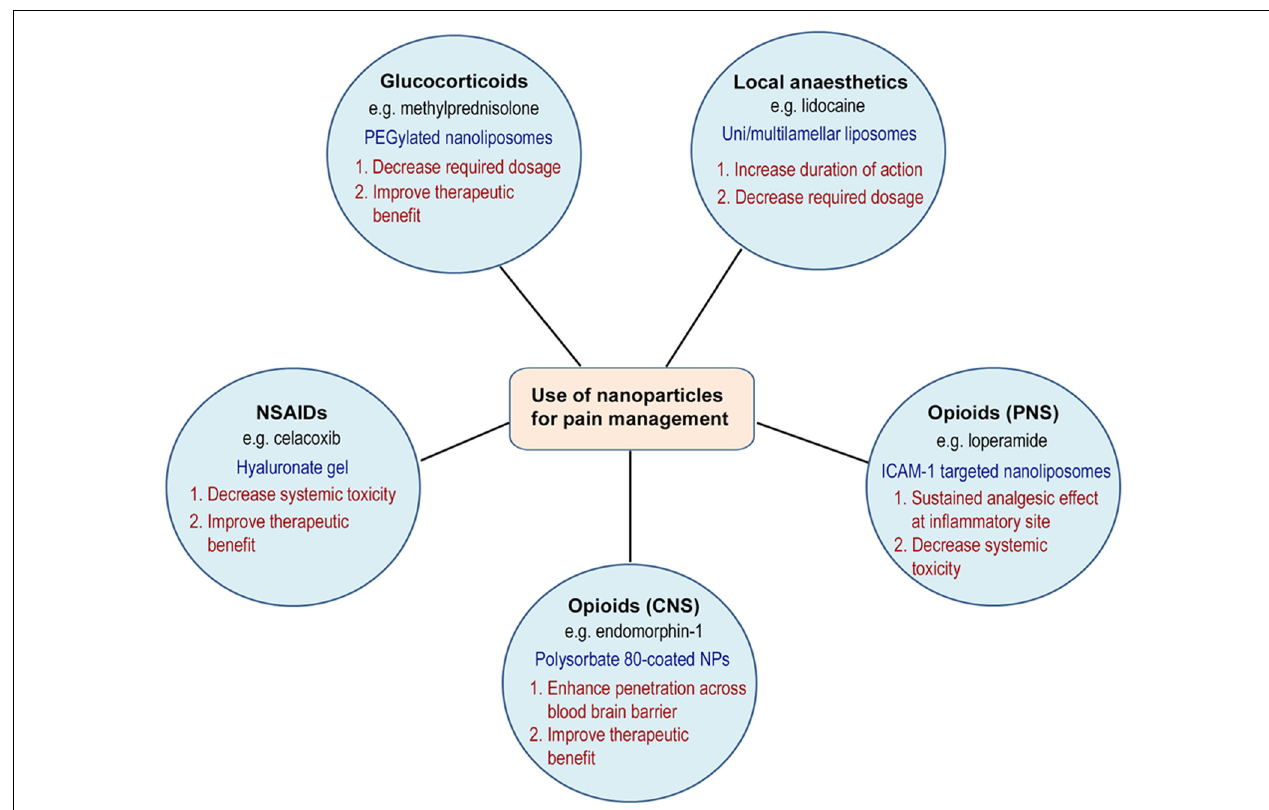
FIGURE 1 | Use of nanocarriers for pain